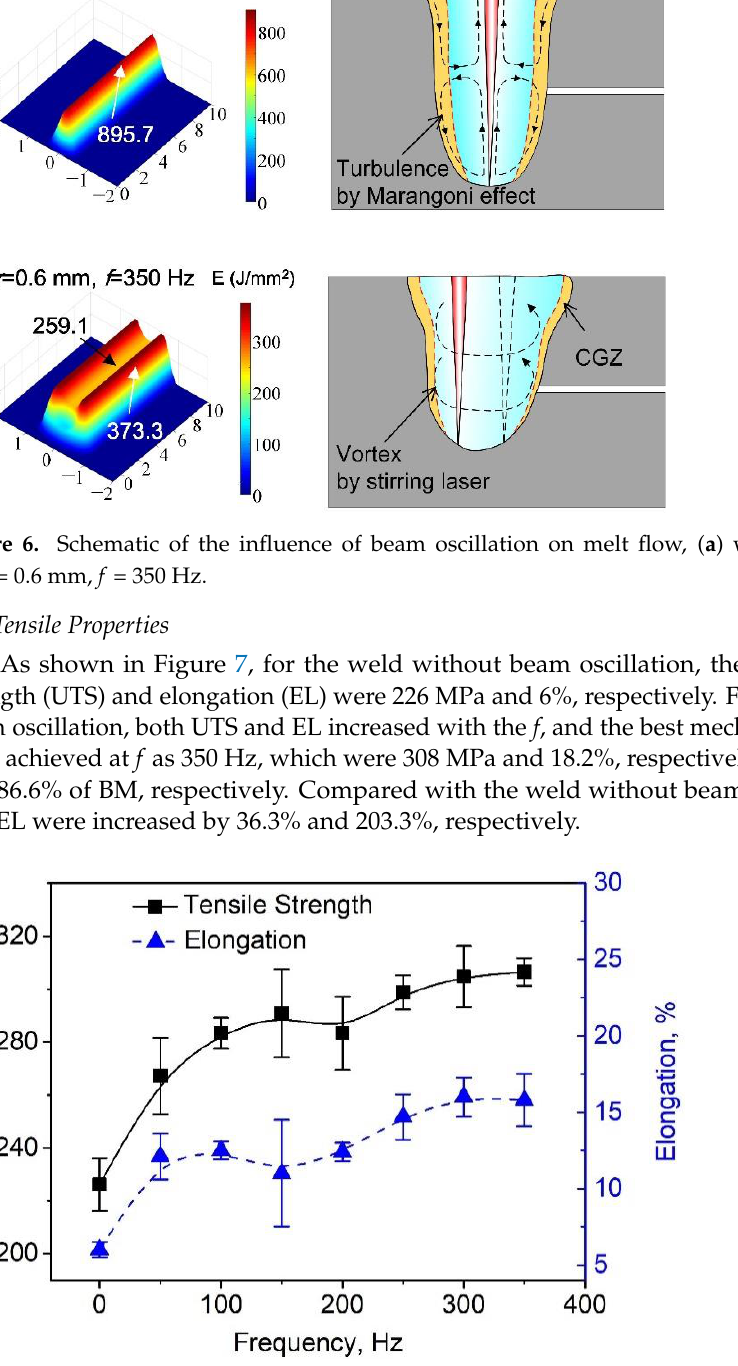
Figure 7. Effect of f on mechanical properties.